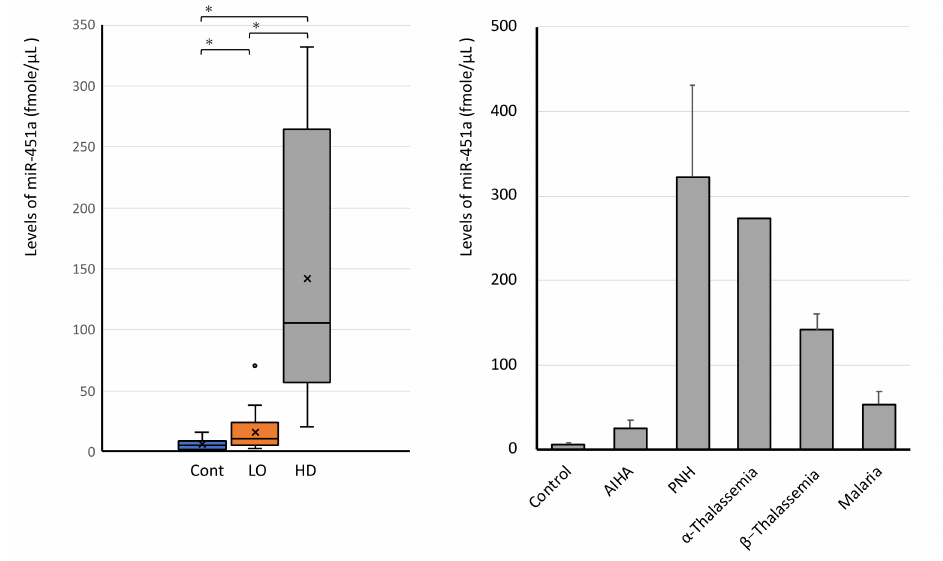
Figure 5. Serum miR451a in 20 patients with hemolytic diseases. The levels of serum miR-451 are shown as calculated values (fmol/ µ L, f: femto, 10 − 15 ). Cont: control subjects ( n = 10), LO: leftover samples ( n = 30), HD: hemolytic diseases ( n = 20), AIHA: autoimmune hemolytic anemia,